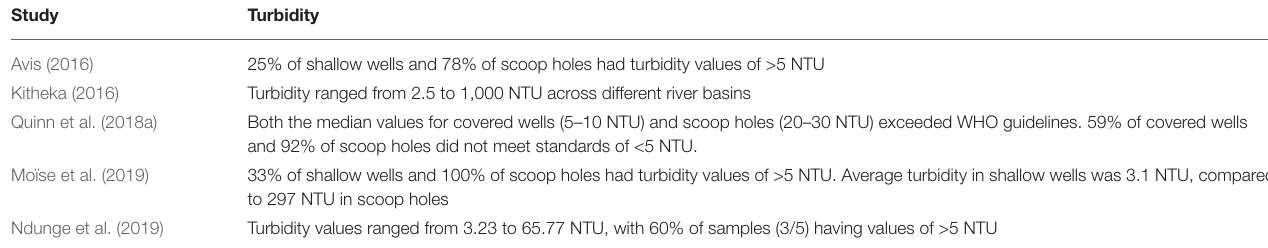
TABLE 6 | Measures of turbidity in different studies.